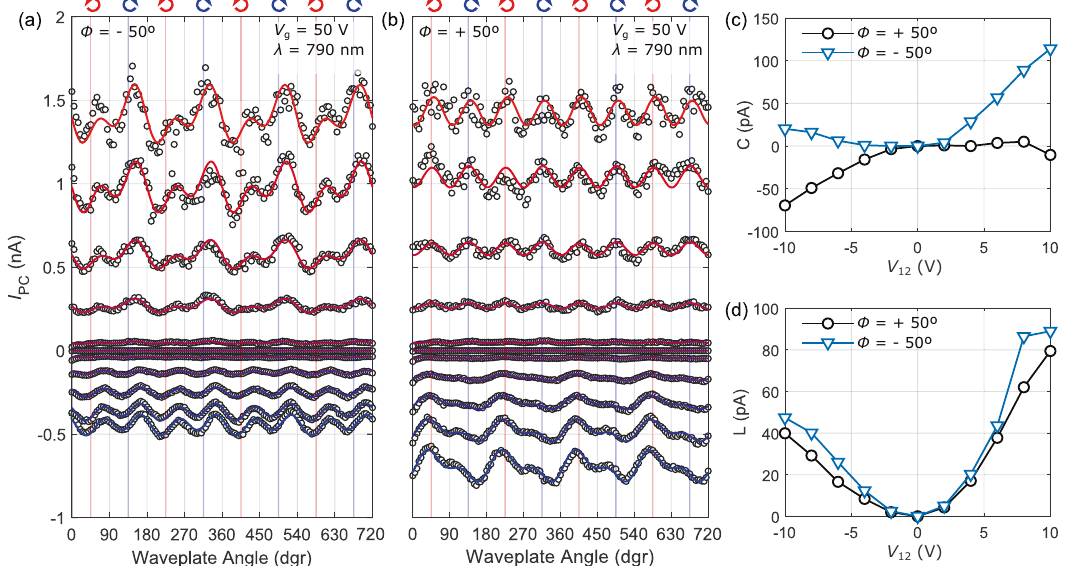
Fig. 5 Dependence of C and L on the drain source voltage. a , b Photocurrent I PC as a function of the waveplate angle for different drain – source voltages V 12 between − 10 V (blue) and + 10 V (red), for a light incidence angles ϕ = + 50° ( a ) and ϕ = − 50° ( b ). Dots indicate experimental data. Solid lines are fi ttings to Eq. 1. c , d Dependence of C ( c ) and L ( d ) on the drain – source voltage, extracted from the fi ttings shown in ( a ) and ( b